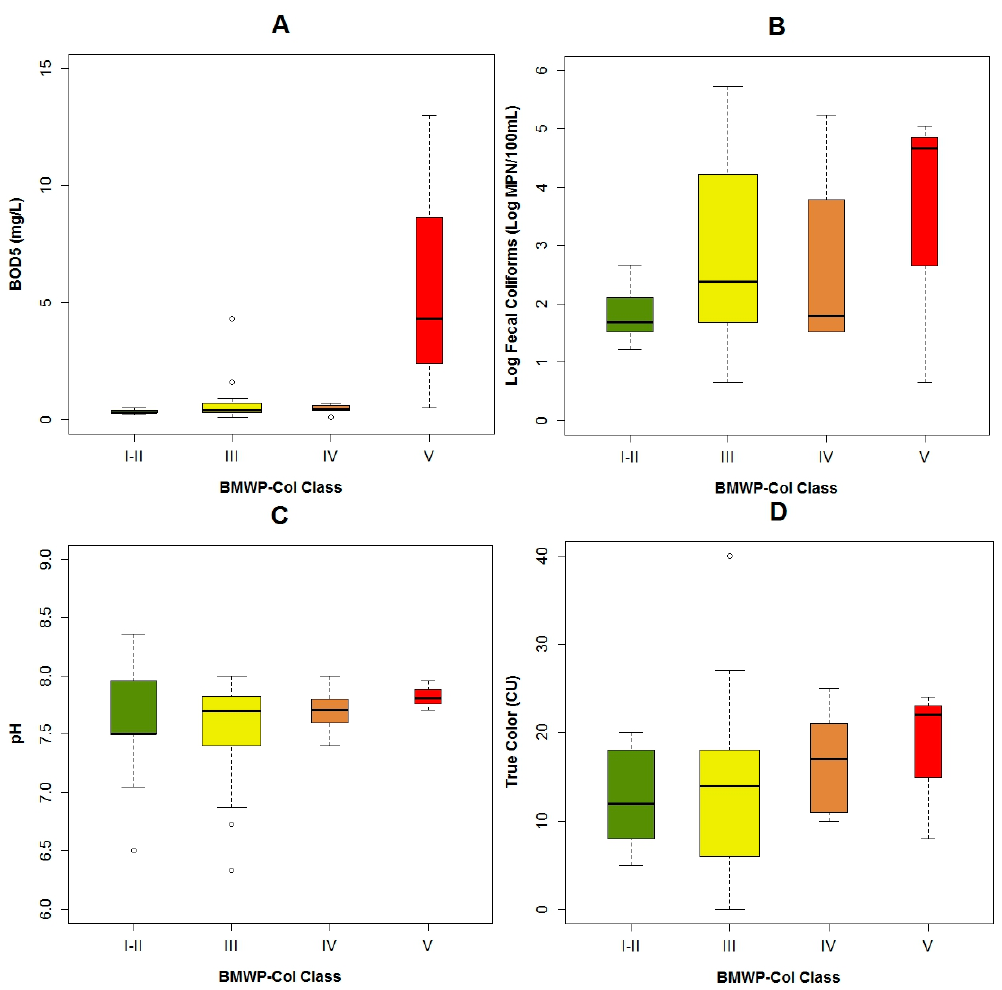
Figure A5. Boxplots of the BMWP-Col with the others explanatory variables of the three models: BOD 5 ( A ); Log fecal coliforms ( B ); pH ( C ) and color ( D ).